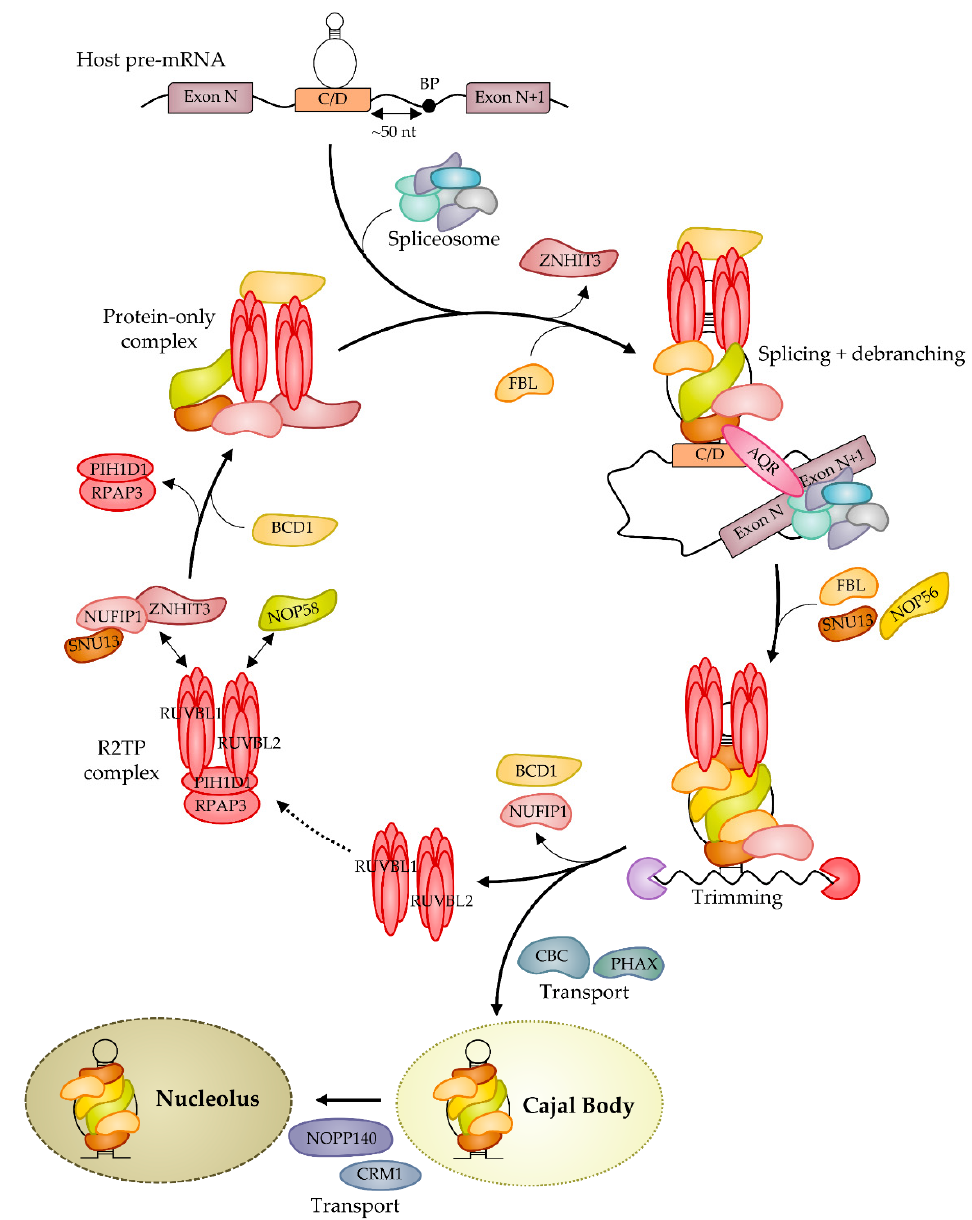
Figure 2. Model of eukaryotic C/D snoRNP biogenesis. The loading of the core proteins SNU13, NOP58, NOP56, and FBL does not occur autonomously in eukaryotic cells but is mediated by several assembly factors. The R2TP complex contains the proteins RUVBL1, RUVBL2, RPAP3, and PIH1D1 and the latter interacts directly with NOP58 to stabilize it. The assembly platform NUFIP1 and its stabilizing factor ZNHIT3 interact with SNU13 to form a trimer. The essential contribution of the assembly factor BCD1 is less clear; it is integrated in a network of interactions involving PIH1D1, NUFIP1, RUVBL1&2, NOP58, and SNU13, which suggests that these proteins form a protein-only pre-snoRNP complex that scaffolds SNU13 and NOP58 core protein assembly. The proteins are then loaded on nascent snoRNA molecules in a co-transcriptional way upon the direct binding of SNU13 to the K-turn structures formed by the conserved C/D motifs. The efficient RNP assembly of intronic snoRNAs is favored by the association of the splicing and biogenesis machineries via the splicing factor AQR. The nucleation of the pre-snoRNP protects the snoRNA from extensive trimming by exonuclease activities. When released, the assembly factors might be recycled in a new biogenesis process (dotted line). Finally, the C/D snoRNPs are transported to CBs and nucleoli for functional purposes. This model is valid in both Saccharomyces cerevisiae and Human.